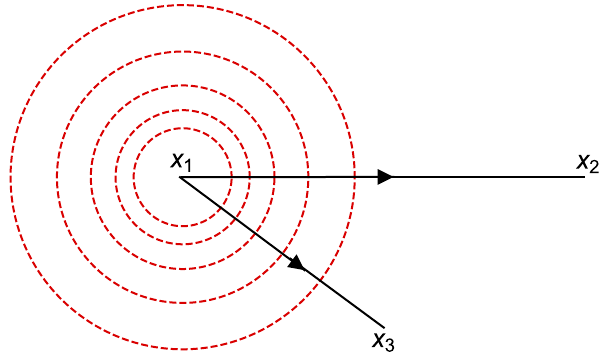
Figure 17 . Three-point correlation function of one unprotected operator located at point x 1 and two protected operators at points x 2 and x 3